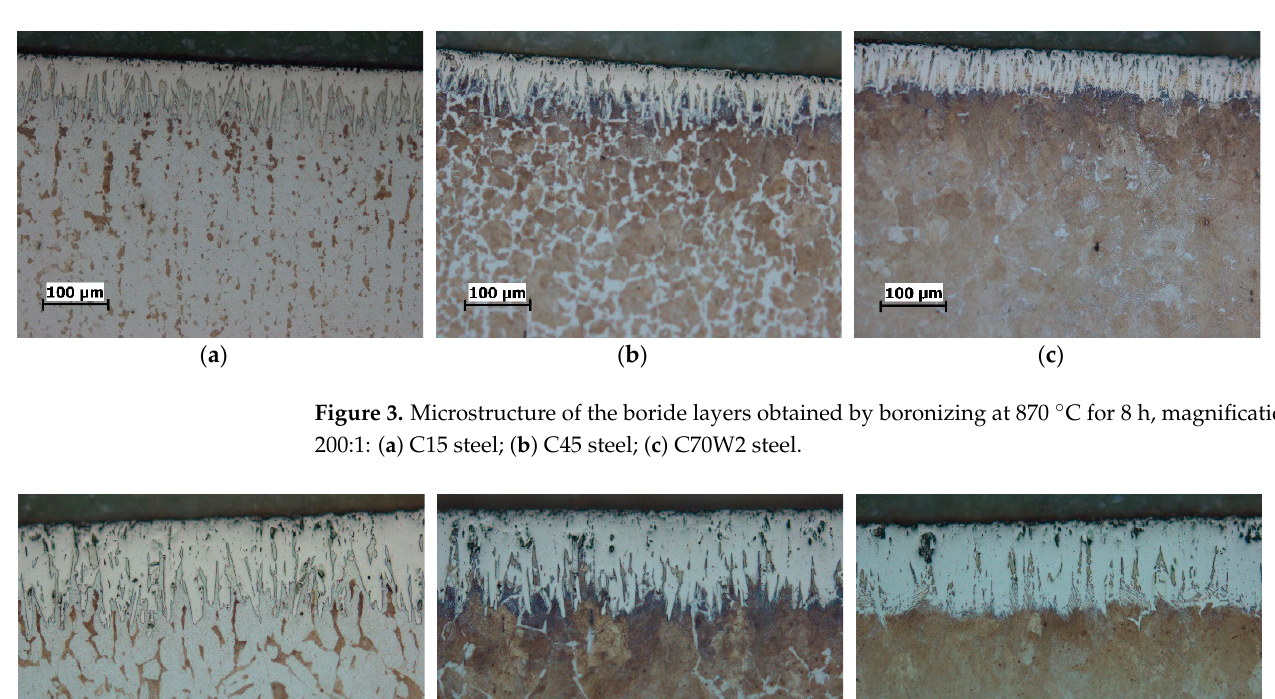
Figure 2. Microstructure of the boride layers obtained by boronizing at 870 °C for 4 h, magnification